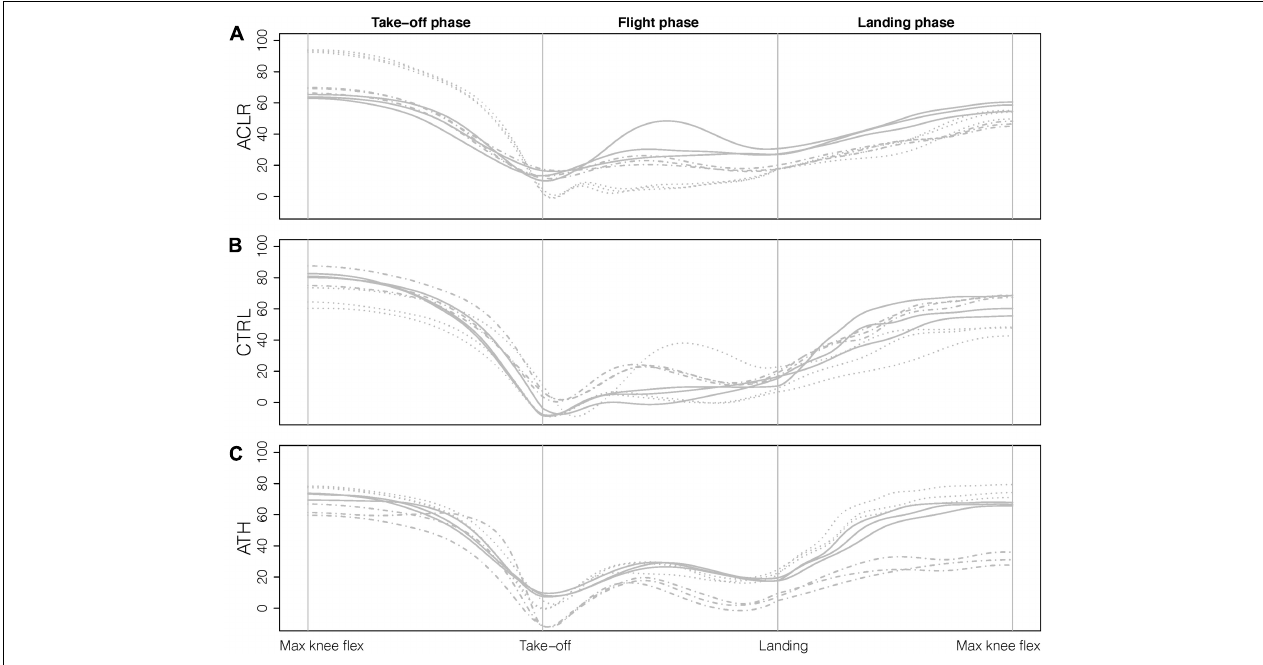
FIGURE 2 | Illustration of the three phases and the landmarks (gray vertical lines) using knee angle data for the sagittal plane. For each group (A) ACLR, (B) CTRL, and (C) ATH, three repetitions for three randomly selected participants are displayed, where different line types correspond to different